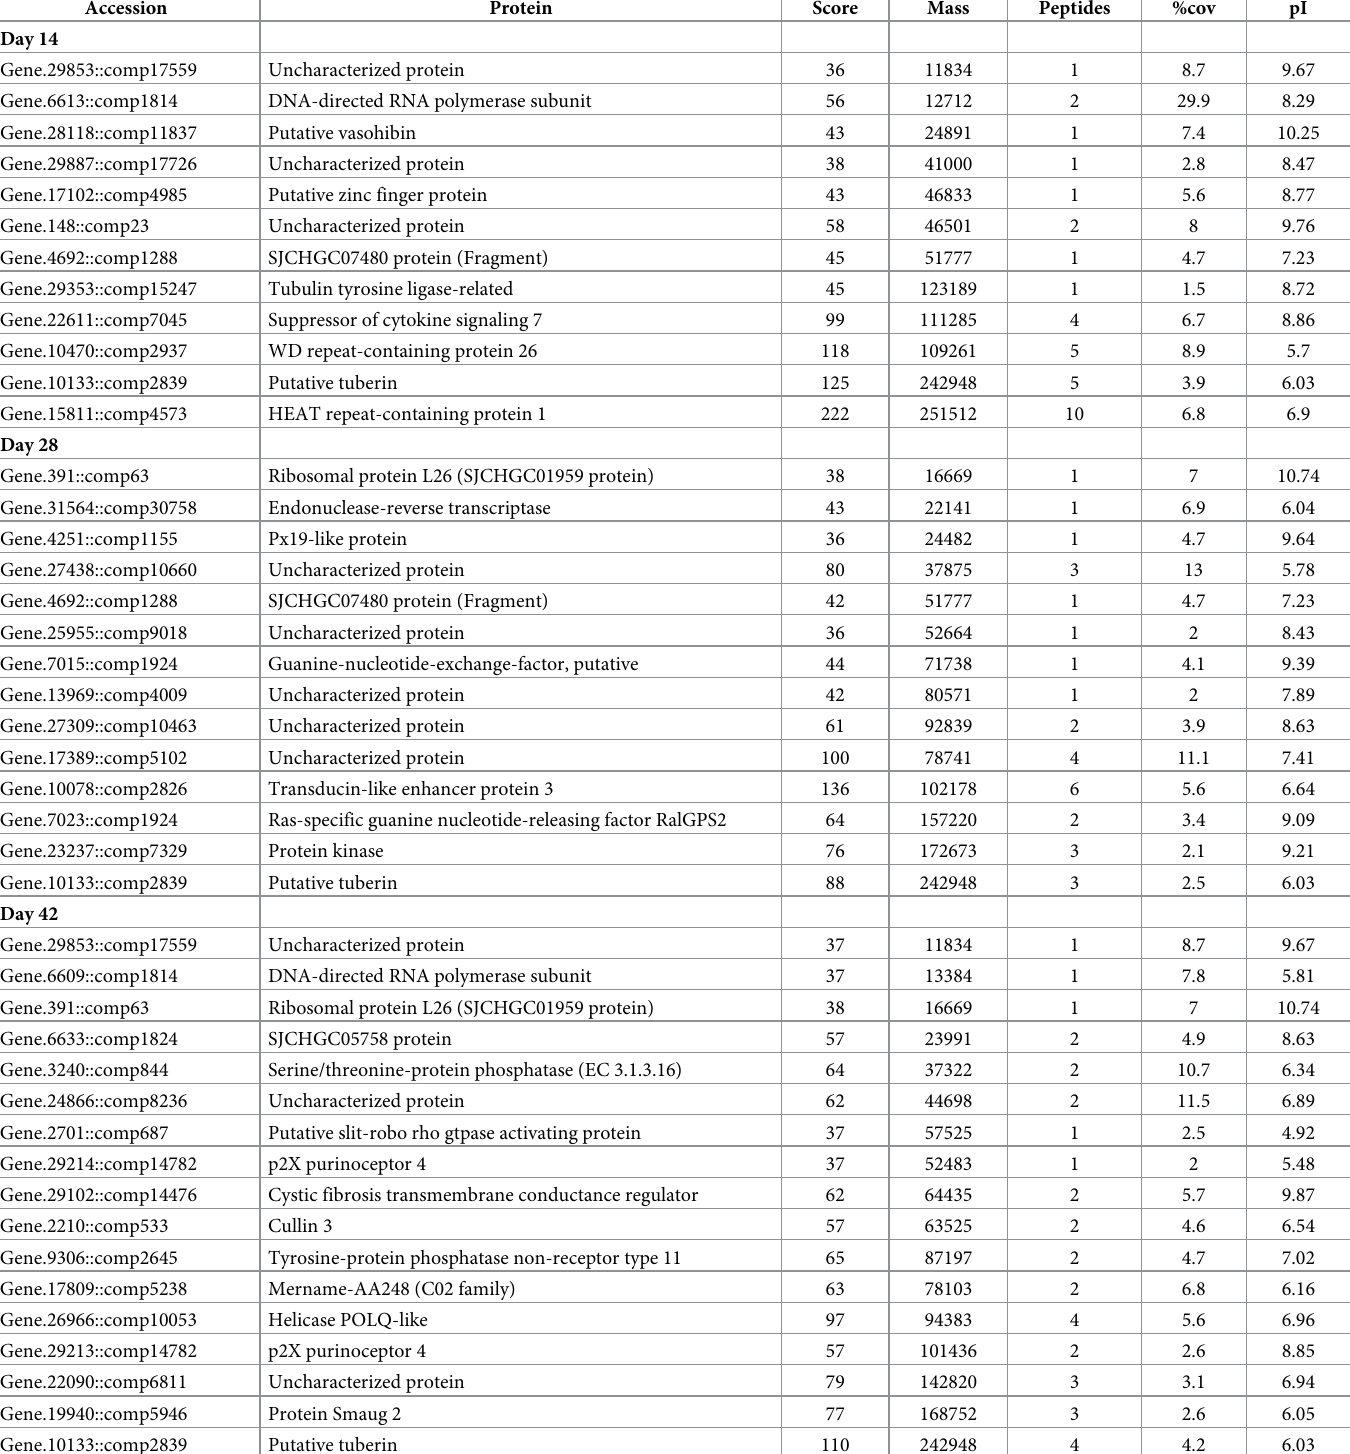
Table 3. Identification of circulating S . mekongi antigens from infected mouse immune complexes at 14-, 28-, 42-, and 56-days post-infection. S . mekongi proteins were identified using LC-MS/MS and the in-house database, with S . mekongi set as the taxonomy